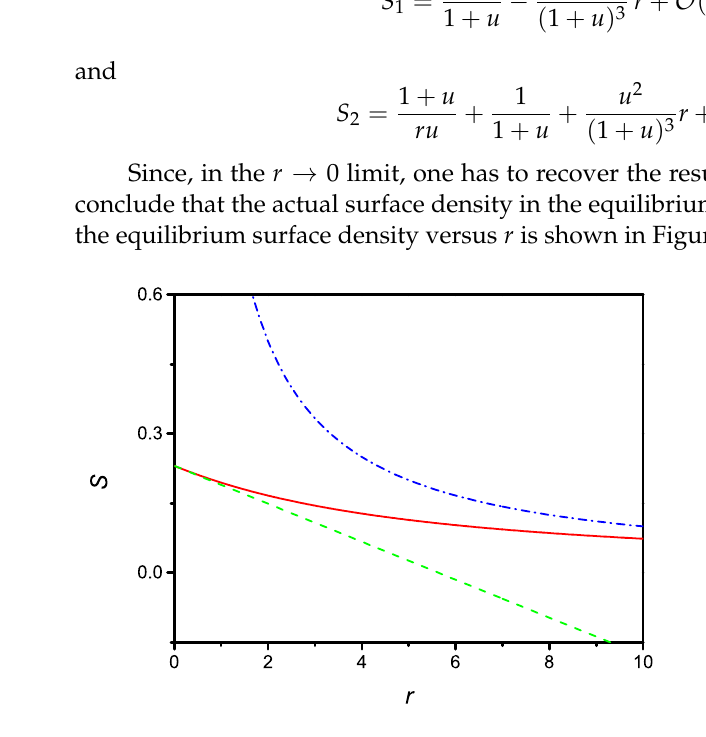
Figure 1. Dependence of the dimensionless surface density of the steady state versus the dimension- less parameter r . Dashed and dash-dotted lines represent the limiting cases corresponding to small and large r , respectively, as given by Equations (21) and (23). The curves are drawn for u = 0.3 or τ = 0.3 τ κ , i.e., the adsorption time is approximately three-times faster than the desorption